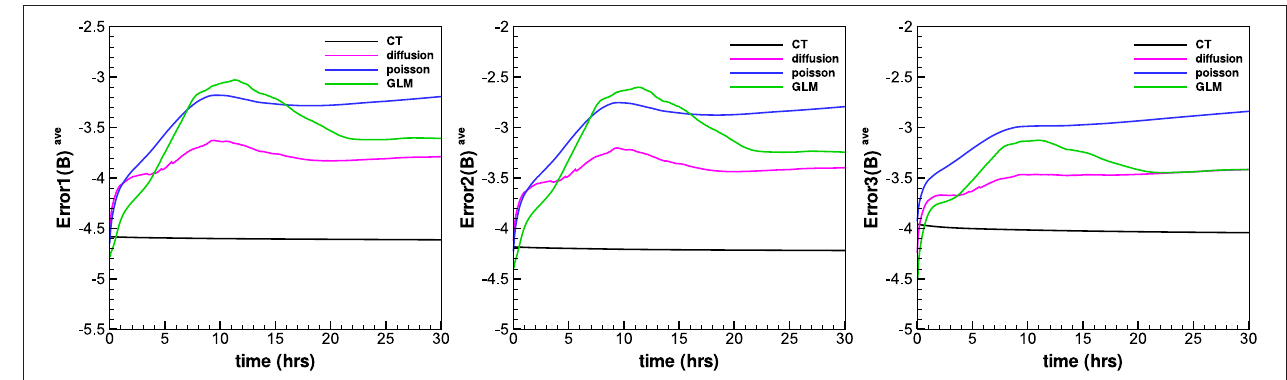
FIGURE 13 | The temporal evolution of the log 10 Error1 (B) ave , log 10 Error2 (B) ave , and log 10 Error3 (B) ave from the four divergence cleaning methods in the calculation.